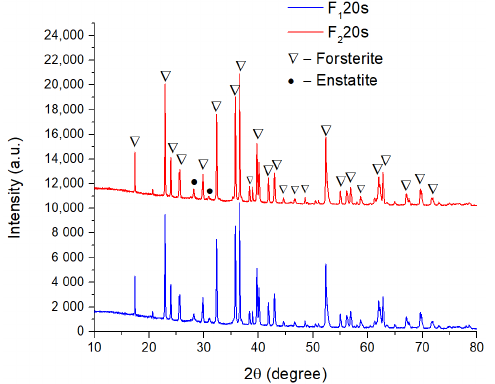
Figure 2. X-ray patterns of forsterite samples: F 1 20s and F 2 20s.